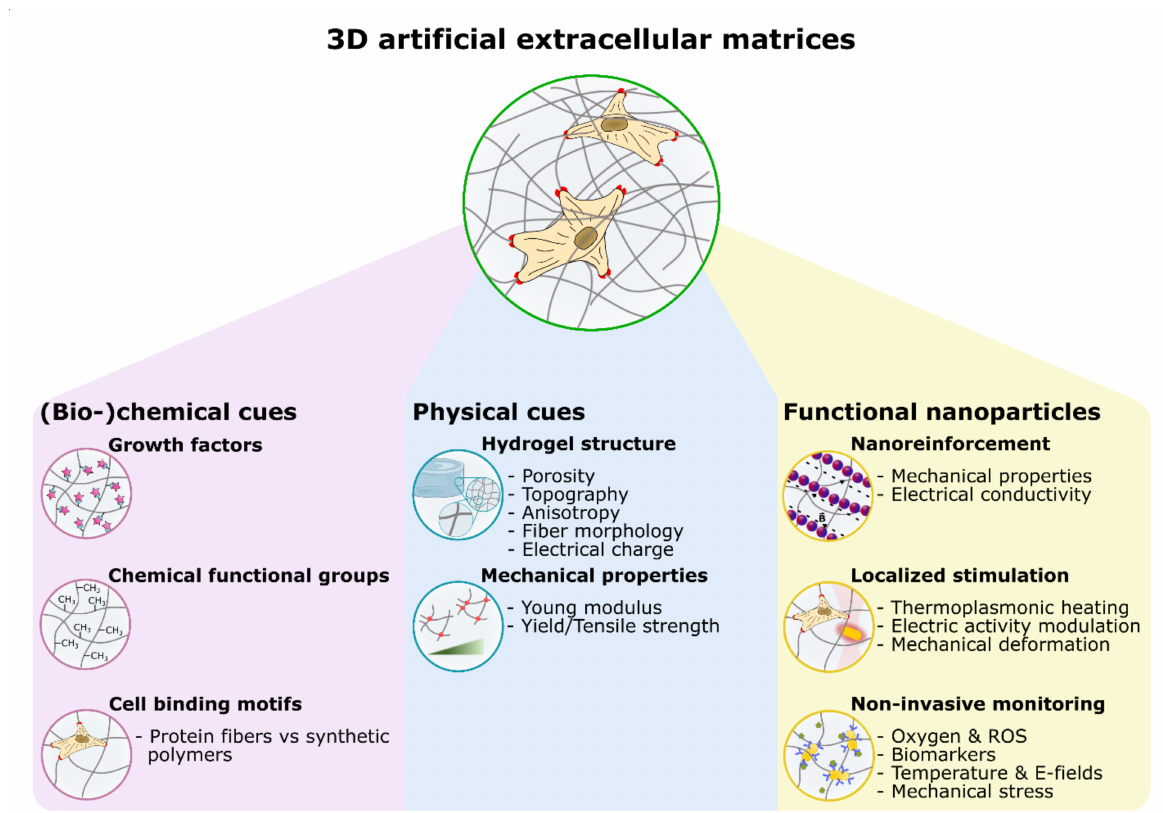
Figure 1. Material toolbox available for mimicking the cell microenvironment. Parts of this figure are adapted with permission from Ref. [6]. Copyright 2017 American Chemical